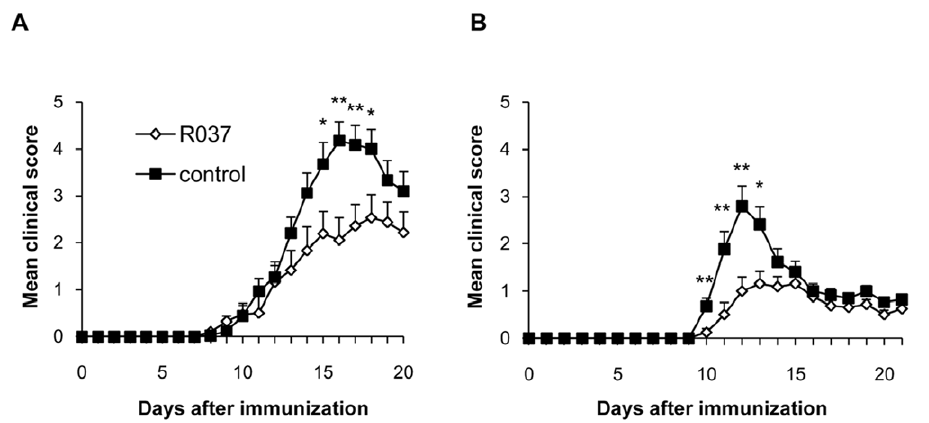
Figure 1. Pediococcusacidilactici ameliorates EAE. (A) R037 (4 mg/day; n=18) or PBS (n=17; control) was administered daily by oral gavages to C57BL/6 mice from 14 days before immunization with MOG 35–55 until the end of the study. (B) R037 (0.8 mg/ml; n=16) or PBS (n=17) in a water bottle was administered to SJL/J mice from 14 days before immunization with PLP 131–151 until the end of the study. Data represent mean score + SEM from a representative of two independent experiments. *p # 0.05; **p # 0.01 (t-test).